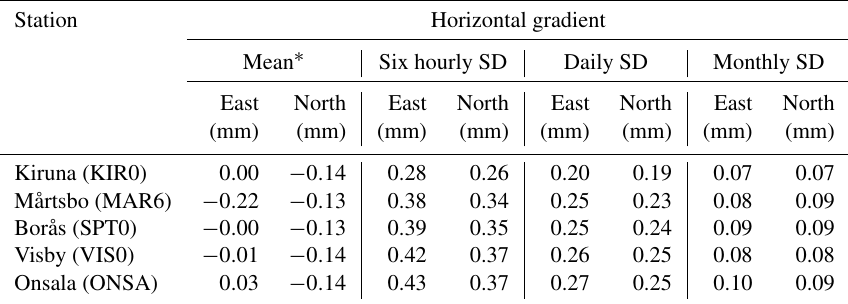
Table 7. Mean values and standard deviations (SDs) over the 11 years of estimated total gradients from ECMWF data for different temporal